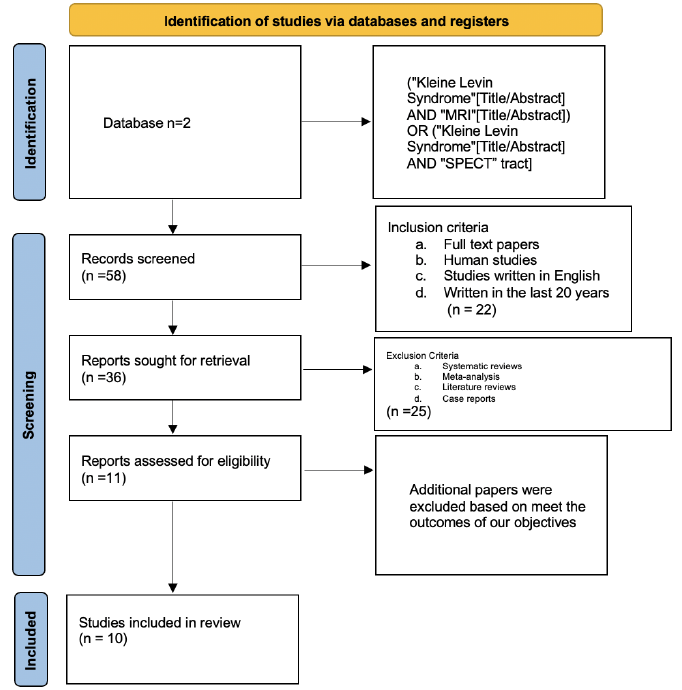
Figure 1. The PRISMA flow chart.